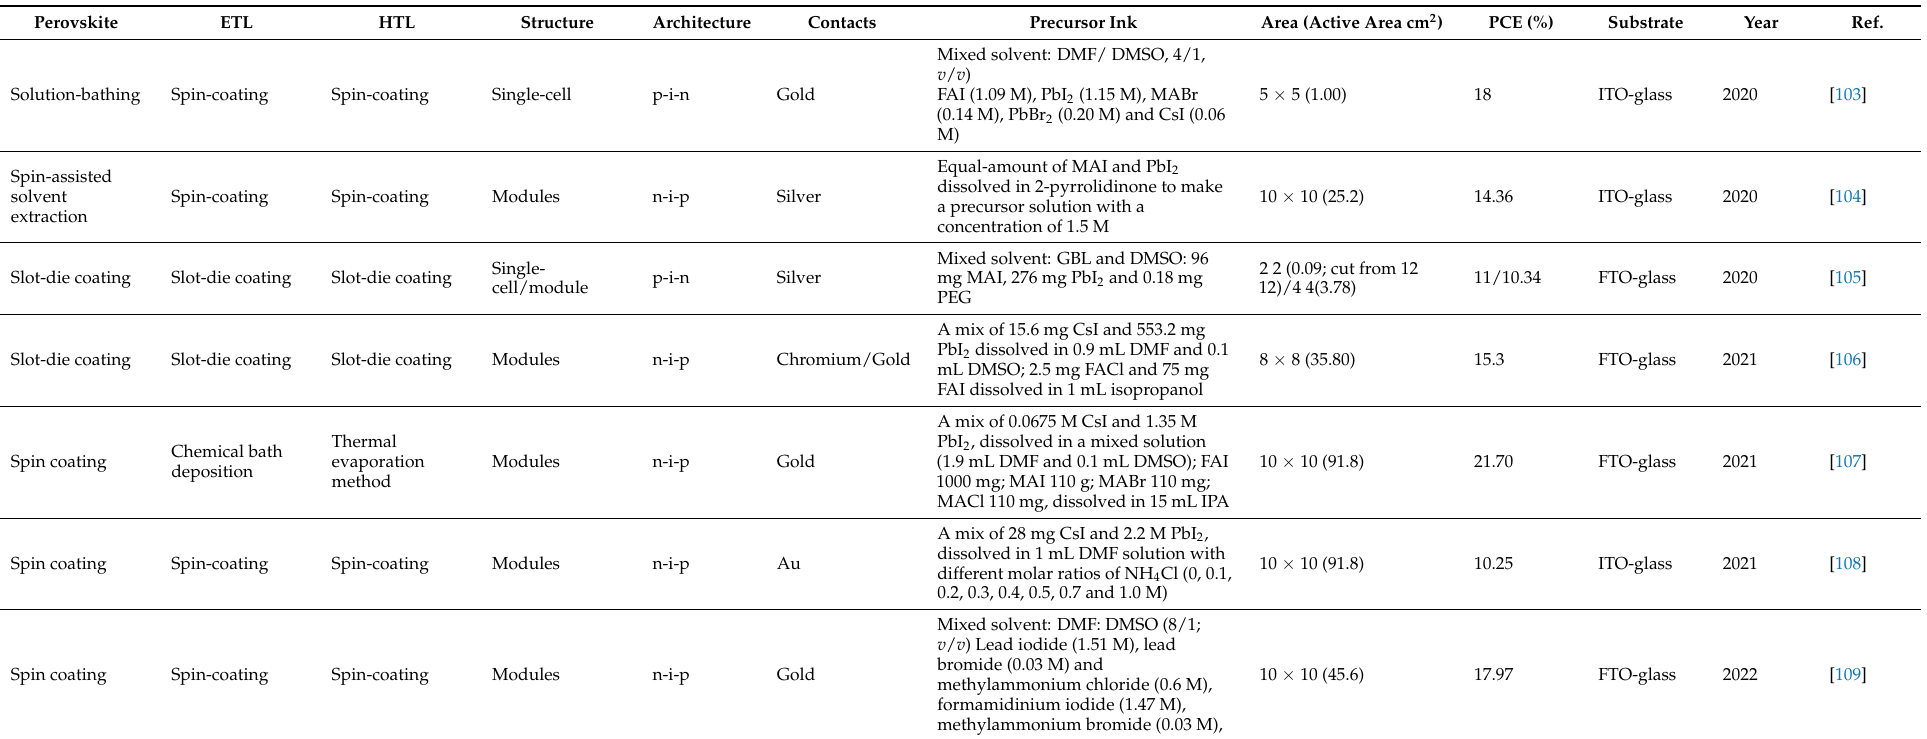
Table 5. Recently reported perovskite solar cell device designs with different techniques for the